Question: Write a single sentence explaining what this figure depicts.
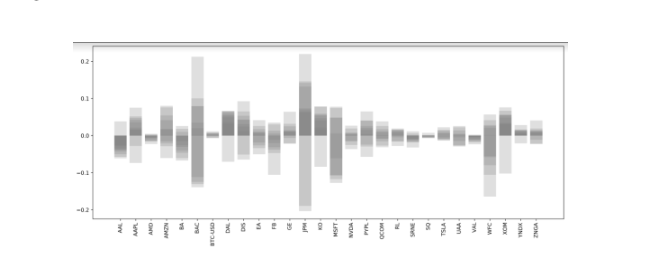
Answer: Performance of Min Variance Model